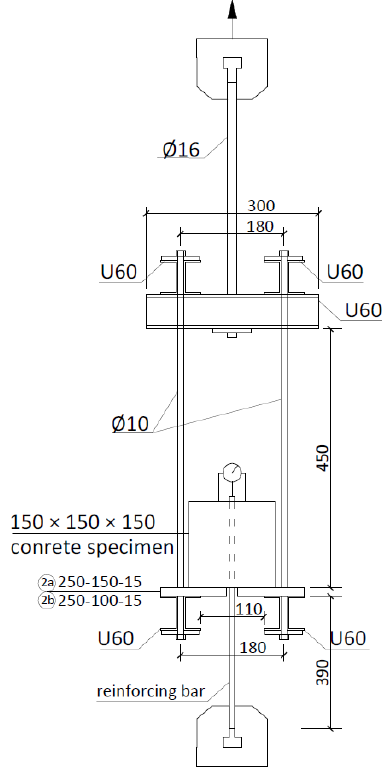
Figure 6. Scheme of the pull-out test (values in mm). Table 2. Composition of (1 m 3 ) mixes.